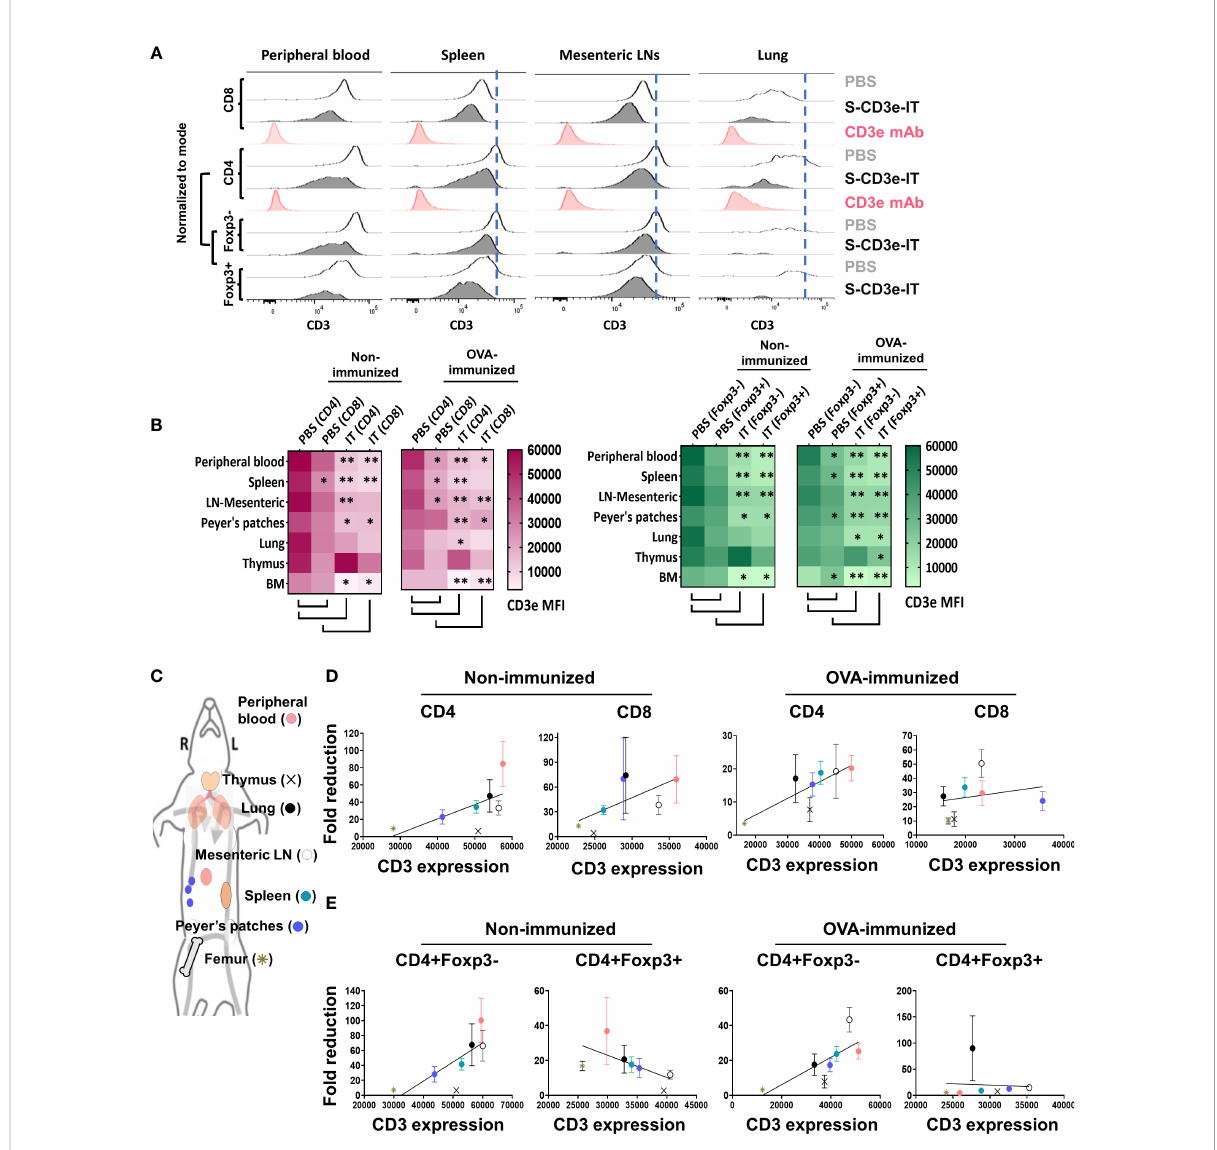
FIGURE 2 Differential CD3e on T cells drive an enrichment of CD3 dim Tregs with organ-to-organ variations. (A) CD3e expression (x-axis) on the CD8+, CD4+, CD4+Foxp3-, and CD4+Foxp3+ cells (y-axis, normalized to mode) are shown for the peripheral blood and tissue-resident portions (IVS-) of spleen, mesenteric LNs, and lungs. (B) Heatmaps show CD3e mean fl uorescent intensities (MFI) for CD4+, CD8+, CD4+Foxp3- and CD4+Foxp3+ cells of all tested organs. Statistical comparison of CD3e MFI on two groups, CD4 (PBS) vs . CD8 (PBS) and PBS-treated vs . S- CD3e-IT-treated mice, is denoted with an asterisk (*) on the heat map. (* p < 0.05 and ** p < 0.01). (C) The diagram shows the symbol of all tested organs in (D, E) . (D) A positive correlation between the fold reductions of CD4+ or CD8+ cell numbers in different organs after CD3e-IT treatment (y-axis) and CD3e MFI of these cells in PBS-treated animals (x-axis). CD4+ and CD8+ lymphocytes for the peripheral blood (red), and tissue-resident (IVS-) portions of the spleen (green), mesenteric LNs (white), Peyer ’ s patches (purple), lung (black), thymus (cross), and bone marrow (asterisk) are compared. (E) A positive correlation between the fold reductions of CD4+Foxp3- cell numbers in different organs after CD3e-IT treatment (y-axis) and CD3e MFI of these cells in PBS-treated animals (x-axis). Note that this correlation was not evident for CD3+Foxp3+ T regs. Nonimmunized mice (PBS n = 4~5, and S-CD3e-IT n = 4~6, depending on organs); OVA-immunized mice (PBS n = 3~4, and S-CD3e-IT n = 7~8, depending on